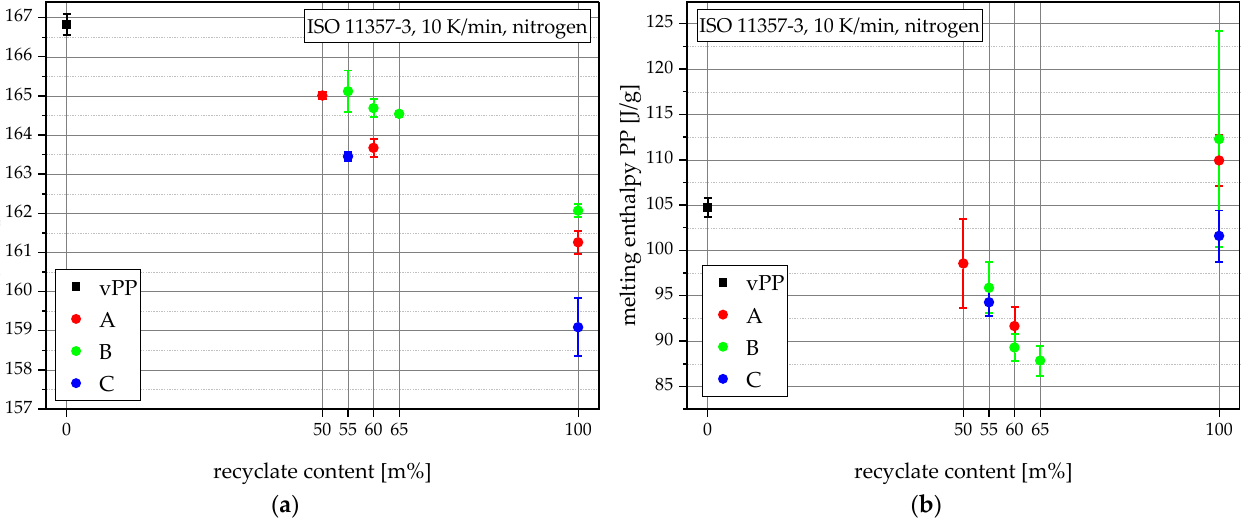
Figure 3. PP melting temperatures ( a ), and PP melting enthalpies ( b ) of all materials.